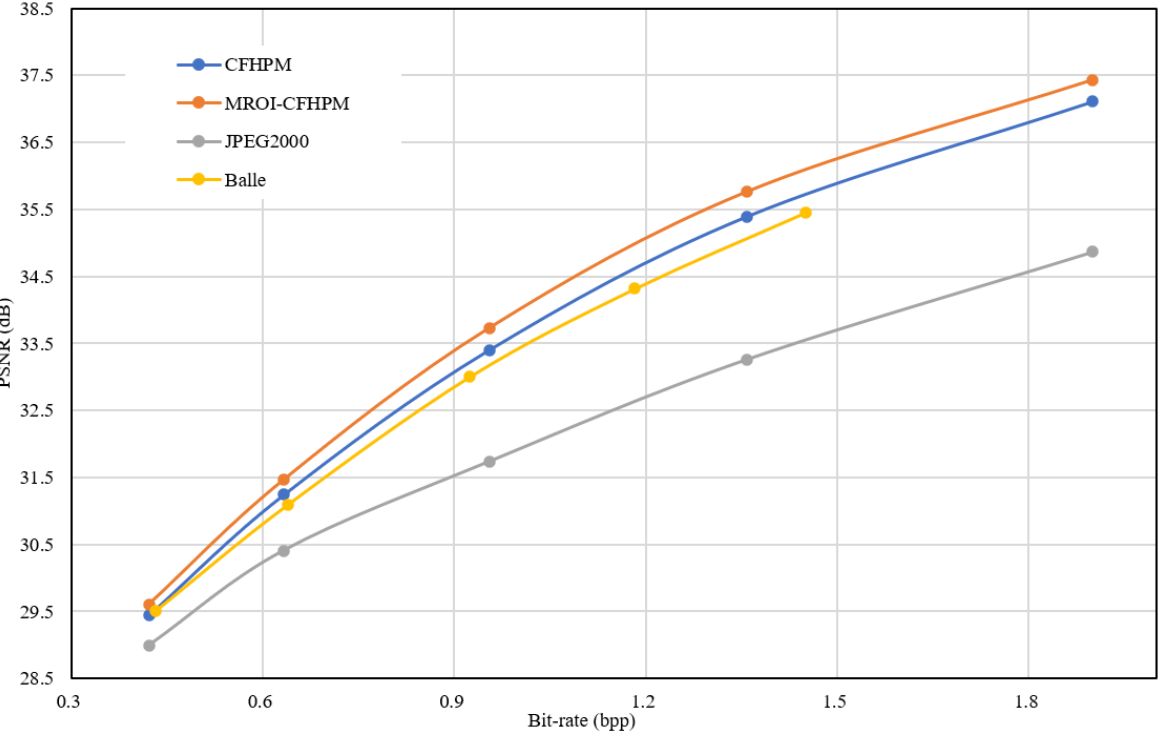
Figure 10. Rate–distortion curves of our proposed MROI-CFHPM against the JPEG2000, CFHPM, and Balle. This PSNR only includes noncloud